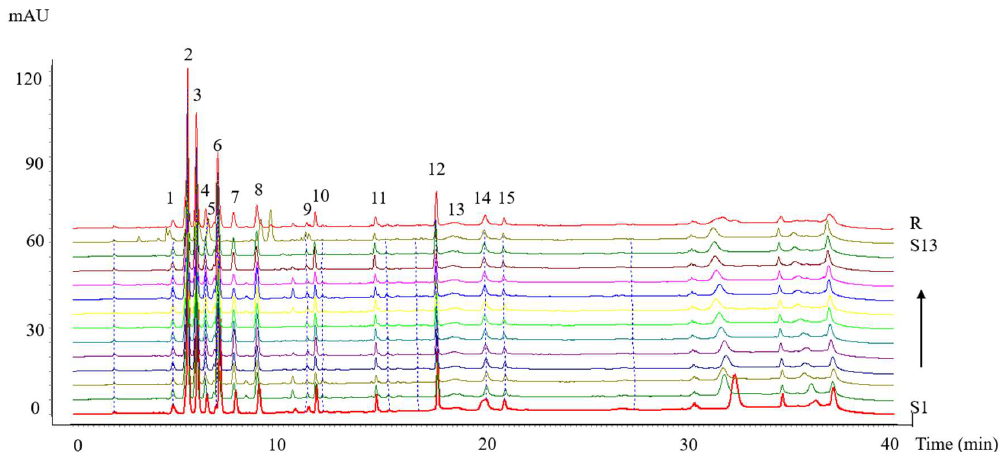
Figure 1. The high-performance liquid chromatography (HPLC) fingerprints of 13 batches of collagen peptide samples (S1–S13) and reference standard fingerprint (R). Table 1. The relative retention time (RRT) and relative peak area (RPA) of the common peaks of the collagen peptides. C.V.%: coefficient of variance.